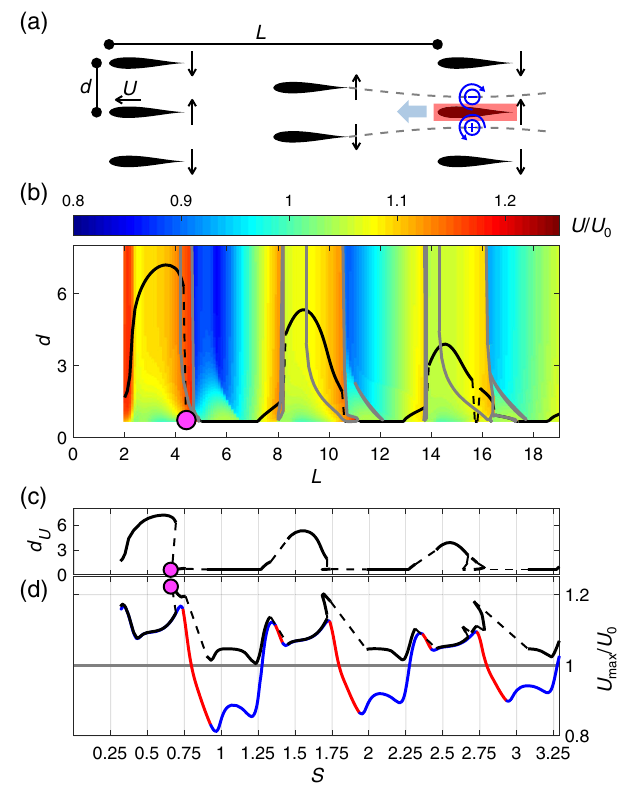
FIG. 7. Speed-up in a diamond lattice. The procedure described in the caption of Fig. 5 is repeated for a diamond lattice. The =U 0 ¼ 1 . 22 for L ¼ 4 . 4 and d ¼ d fastest state has U av corresponding to S ¼ 0 . 67 .